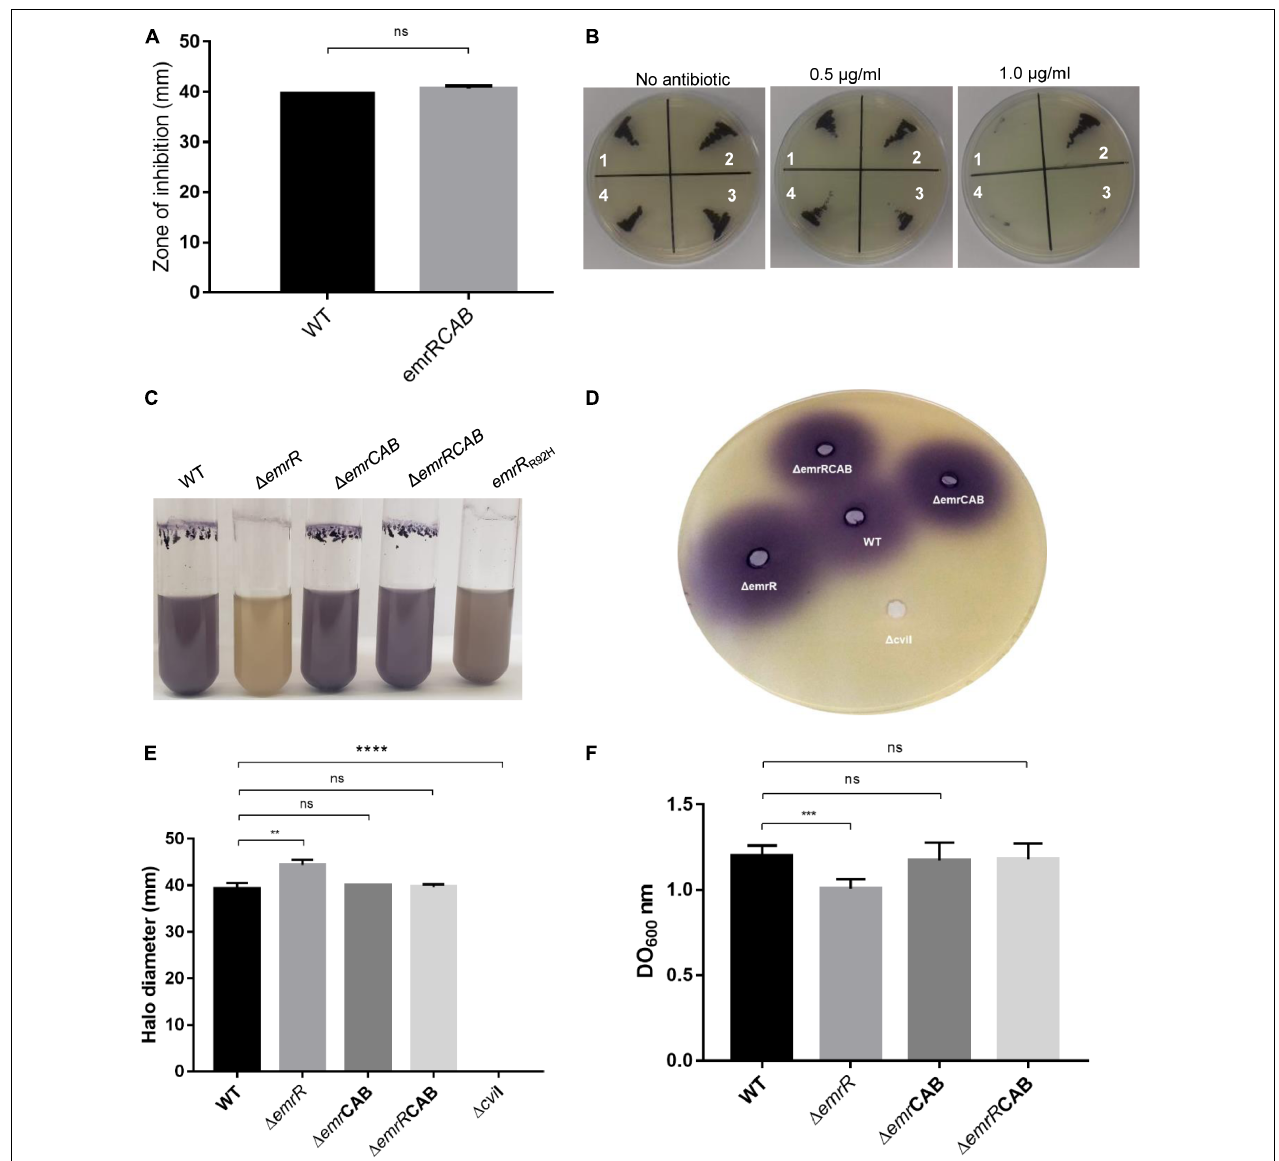
FIGURE 7 | The phenotypes of increased antibiotic resistance and decreased violacein production in (cid:49) emrR are relieved by deletion of emrCAB in this mutant strain. (A) Disk diffusion assays for nalidixic acid performed on MH plates in triplicate with the indicated C. violaceum strains. The error bars indicate standard deviations. (B) MIC assay on LB plate with increasing concentrations of nalidixic acid: (1) C. violaceum ATCC 12472; (2) (cid:49) emrR ; (3) (cid:49) emrCAB ; (4) (cid:49) emrRCAB . (C) Production of violacein in the C. violaceum strains. The indicated strains were grown in LB broth at 37 ◦ C for 24 h. The emrR R92H mutant produces a little more violacein than the (cid:49) emrR mutant does, but both strains have decreased violacein production. (D,E) Quantification of violacein production in the biosensor strain (cid:49) cviI (poured into the agar) stimulated by supernatants of the indicated strains revealed that (cid:49) emrR accumulates extracellular AHLs. Supernatant of a (cid:49) cviI culture was used as negative control. (F) Quantification of biofilm production by the indicated strains grown under static conditions. P -values were determined by t -test Student: ∗∗ P = 0.0061; ∗∗∗ P < 0.001; ∗∗∗∗ P <